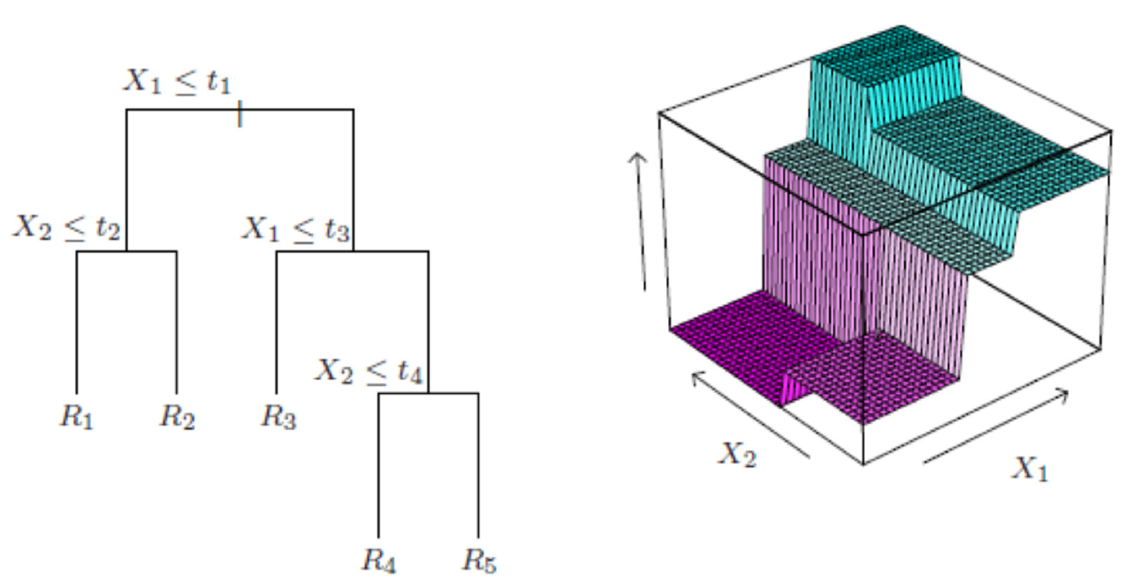
Figure 1. Partition of feature space in a regression tree [17].